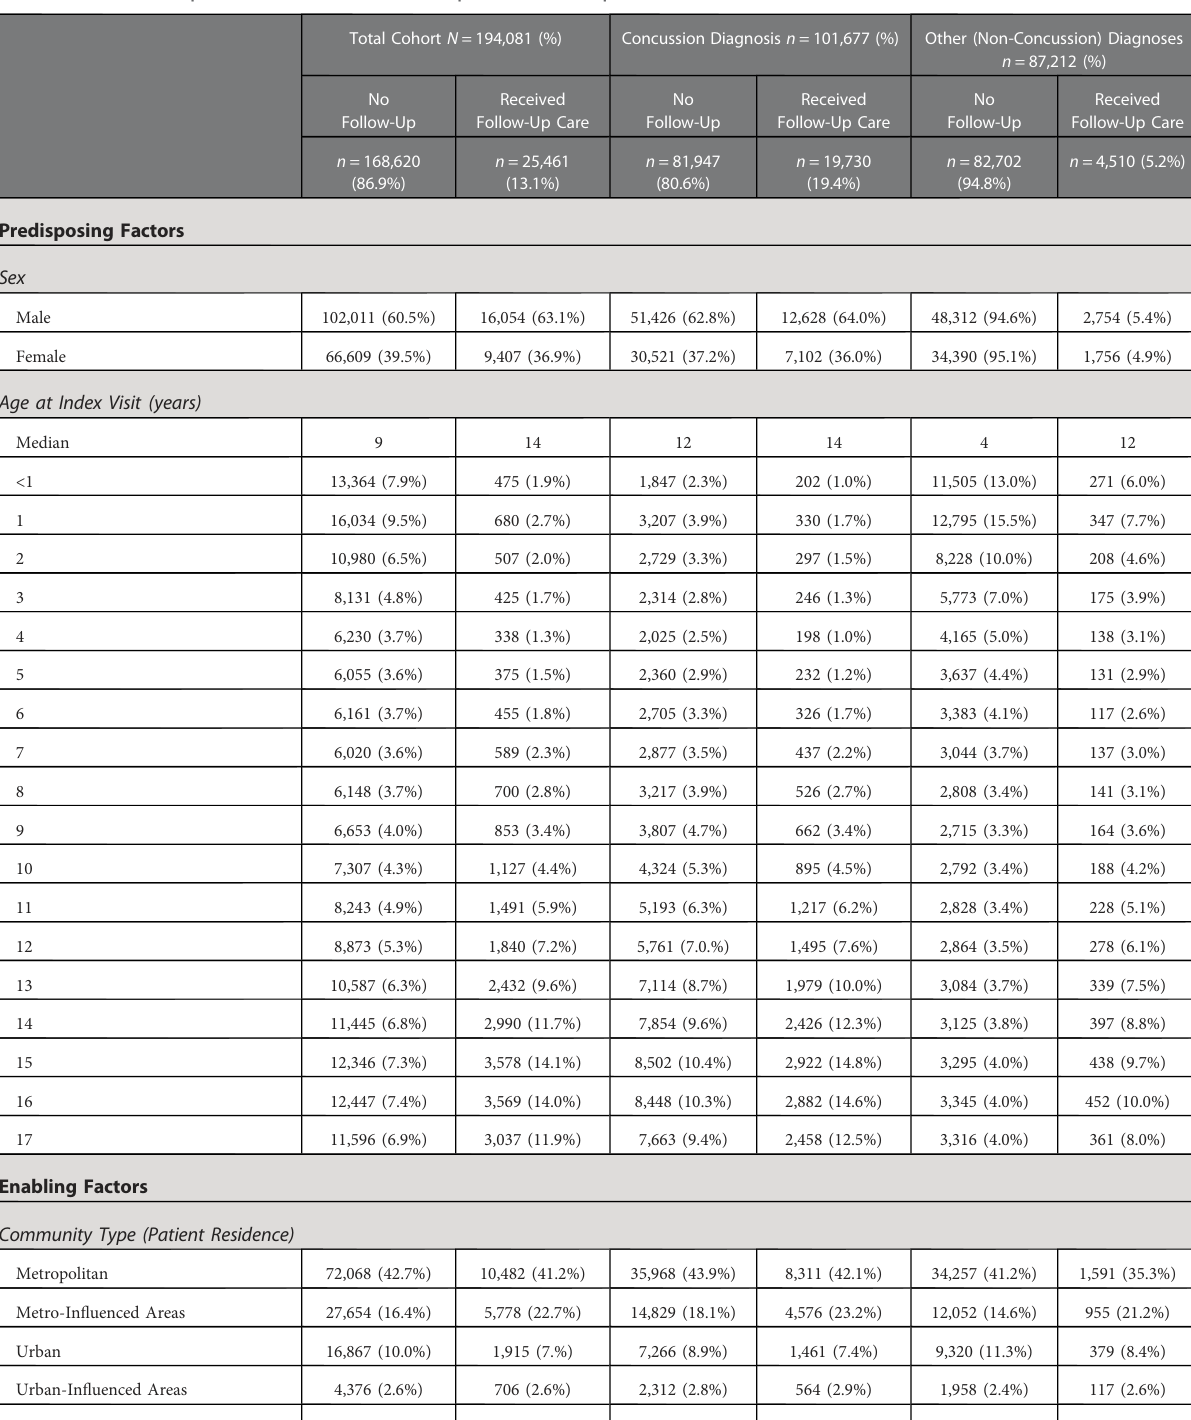
TABLE 5 Demographic characteristics of pediatric concussion, post-concussion syndrome, other speci fi ed injuries of head, and unspeci fi ed injury of head EOC with follow-up care vs. EOC without follow-up care between April 1, 2004 and March 31, 2018 in